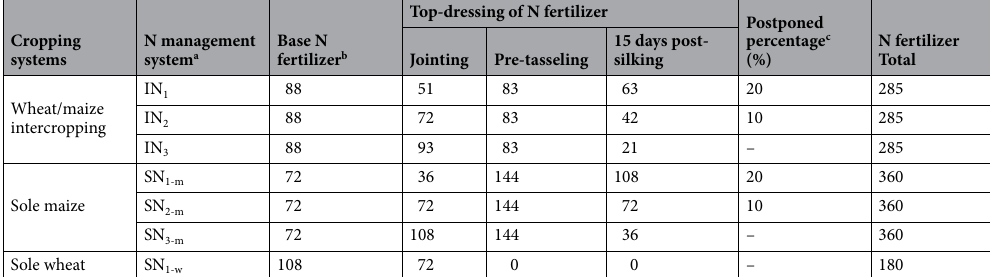
Table 5. N fertilizer allocation amount (kg ha −1 ) and percentage in each treatment. a For sole maize, N 1 , N 2 and N 3 represent N-fertilizer applied at 36, 72, and 108 kg N ha −1 as first top-dressing plus 108, 72, and 36 kg N ha −1 at third top-dressing, respectively. For sole wheat, N 1 represents the N-fertilizer applied